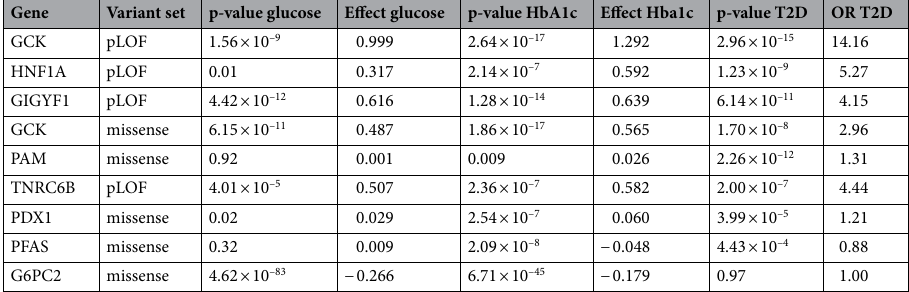
Table 3. Genes and variant sets associated with multiple diabetes-related traits. Variant sets significant for at least one trait in our primary analysis that are also associated with additional diabetes traits (p ≤ 0.0016, 32 sets tested) are shown. Effect is shown in SD of transformed values or as an odds ratio